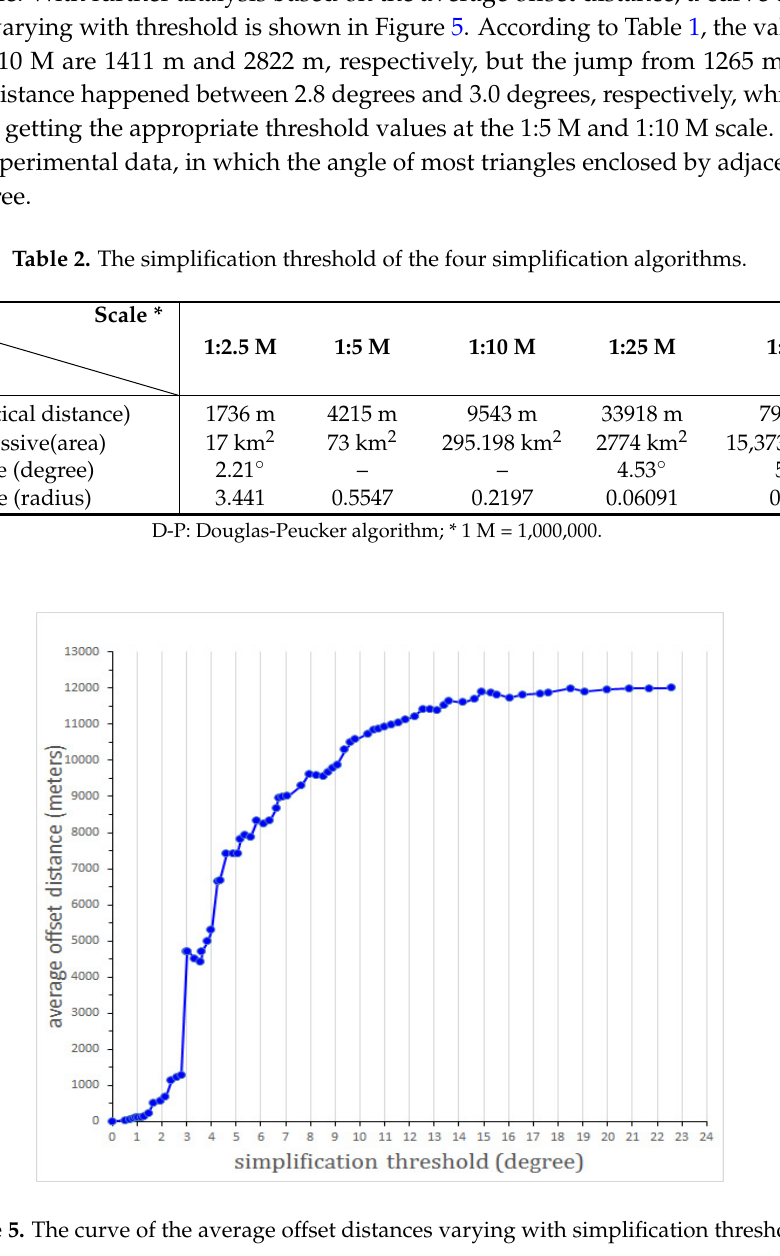
Figure 6. The simplification results of four algorithms.